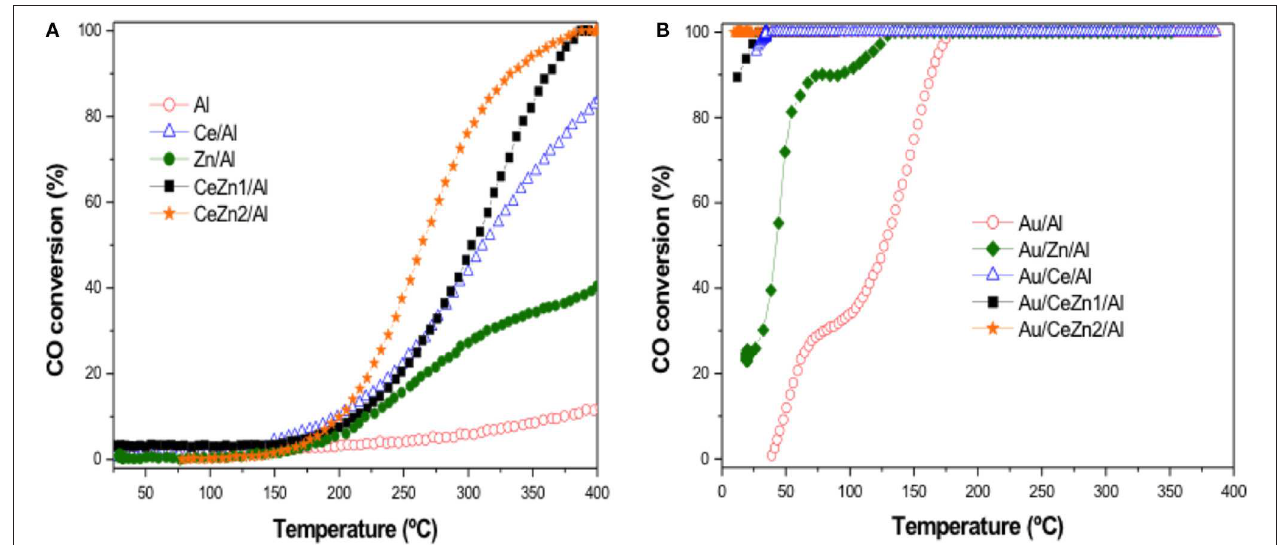
FIGURE 5 | CO oxidation activity (A) supports test (B) gold catalysts.